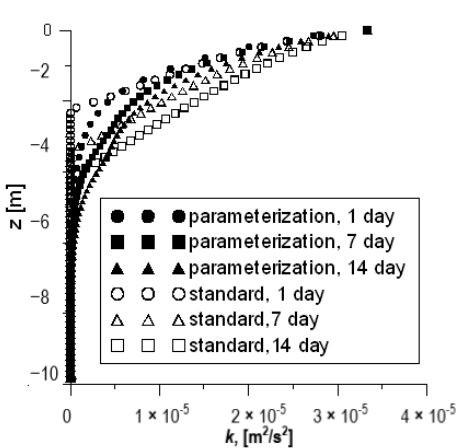
Figure 3. Profiles of the kinetic energy of turbulence in different days of calculation using the standard and modified schemes in the first numerical experiment.